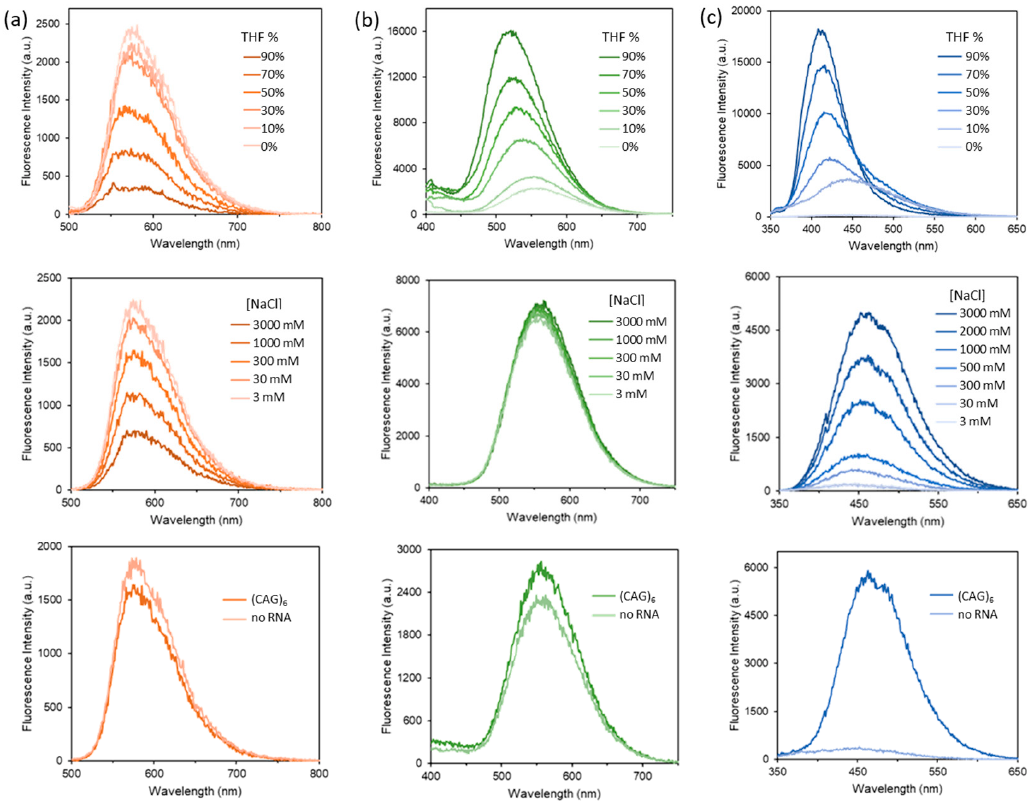
Figure 3. Fluorescence spectra of 10 µ M ( a ) DB-Res ( λ ex = 475 nm), ( b ) DB-Dan ( λ ex = 330 nm), and ( c ) DB-TPE ( λ ex = 300 nm) in different water/THF ratios (upper panel), ionic strengths with various NaCl concentrations (middle panel), and the presence of 1 eq. of a (CAG) 6 RNA (lower panel).